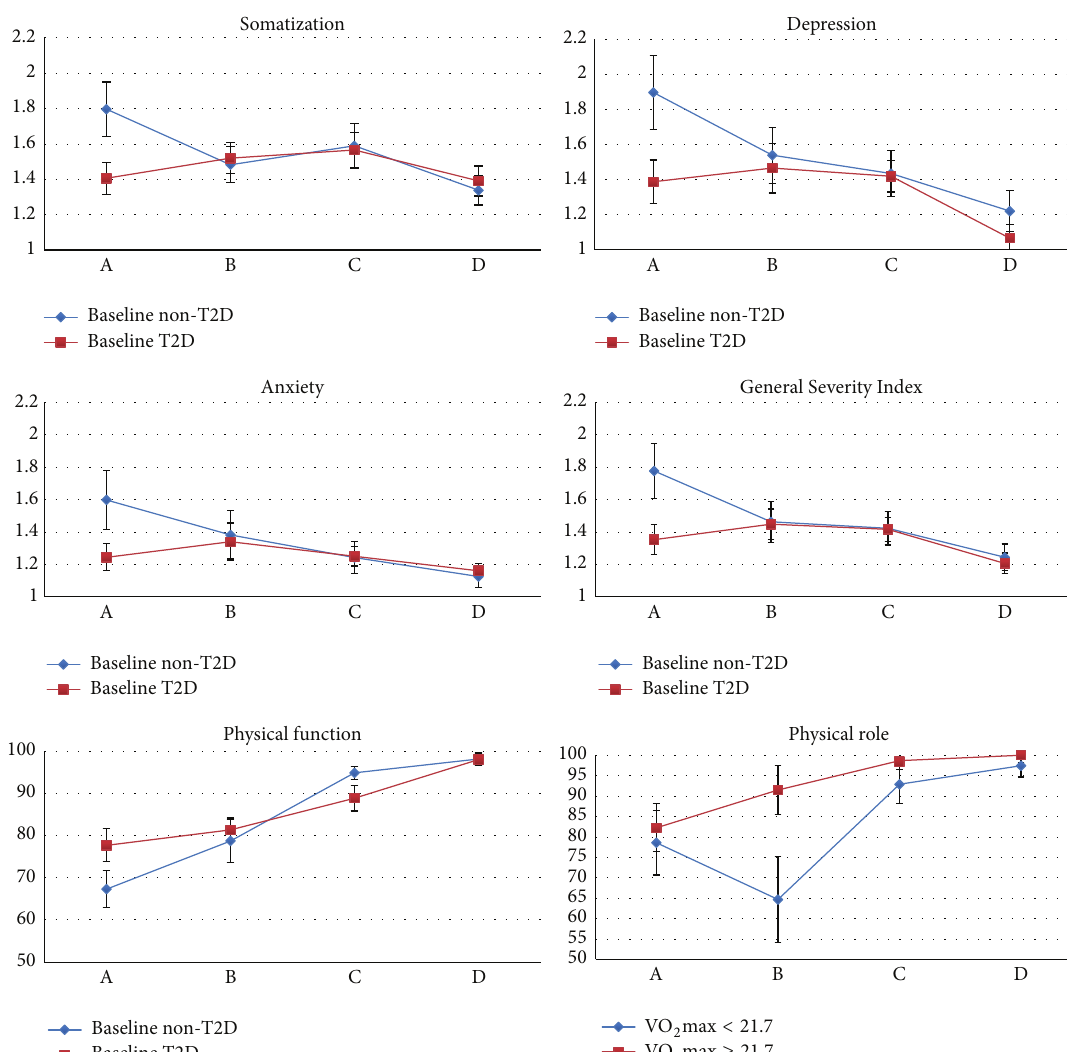
Figure1:Estimatedmeansandstandarderrors(bar)acrossfollow-upsforpatientswithandwithouttype2diabetesatbaseline.Onlysubscales with a significant interaction effect of type 2 diabetes and follow-up are illustrated. The somatization, depression, anxiety, and General Severity Index (GSI) subscales of the “Symptoms Checklist” (SCL-90) are scored from 1 to 4 with higher scores indicating more mental distress. The physical function and physical role subscales of the “Short Form Health Survey 36” (SF-36) are scored from 1 to 100 with higher scores reflecting better health-related quality of